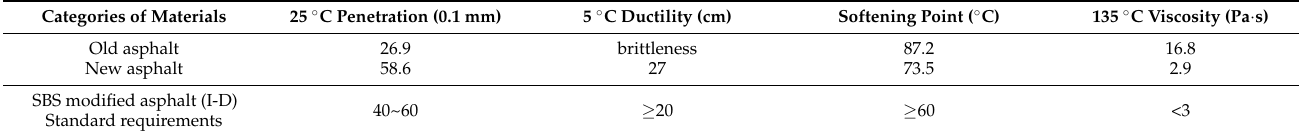
Table 1. Test results of conventional indexes of new and old asphalt.